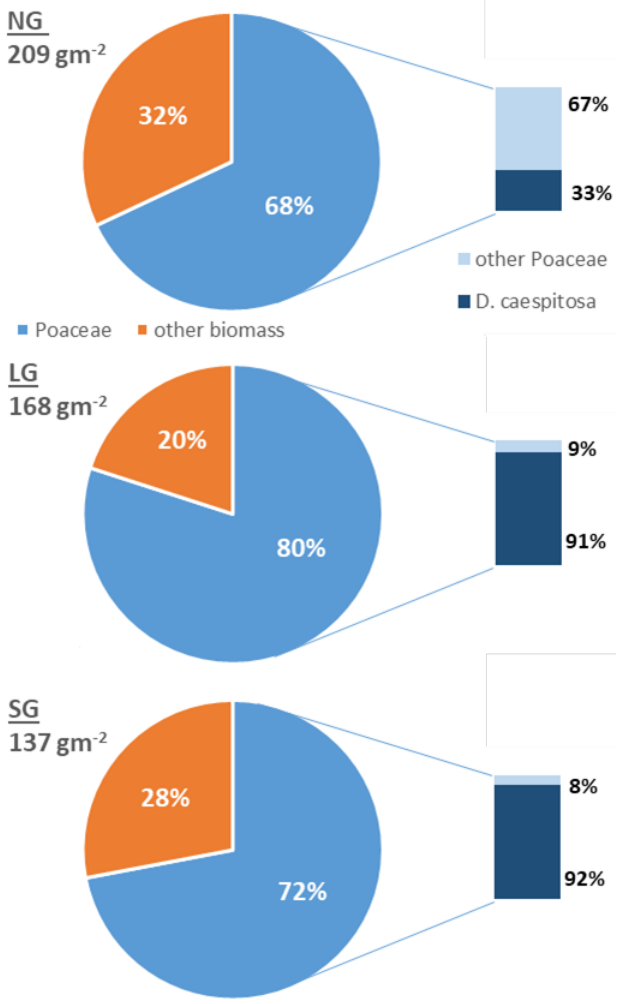
Figure 1. Percentage contribution of graminoids to total biomass and fractions of D. caespitosa in graminoid biomass. Total biomass is given in black.